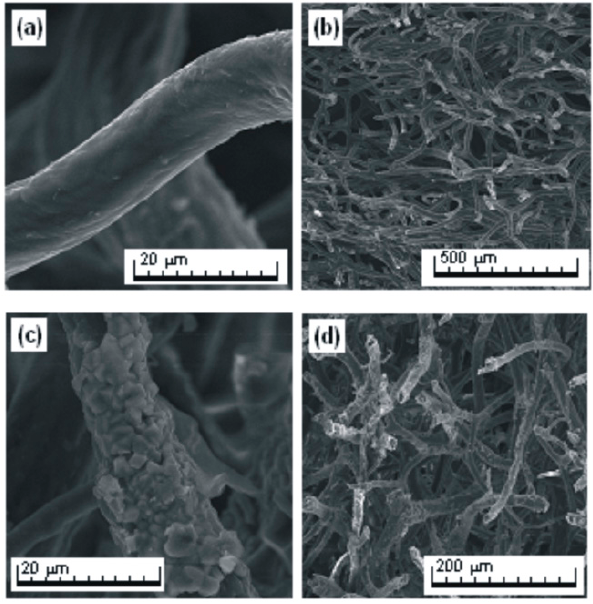
Figure 10. SEM images of purified H. communis sponge skeletons before ( a , b ) and after ( c , d ) adsorption of SCC, at different magnifications.